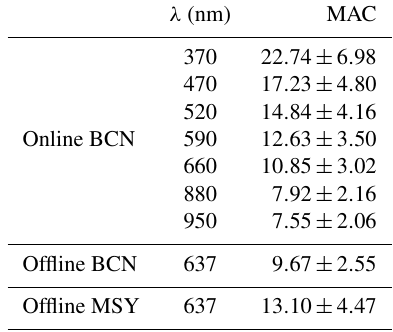
Table 1. Observed MAC (m 2 g − 1 ) values obtained using online techniques via AE33 and Sunset online EC measurements at BCN for a PM 2 . 5 inlet cut-off, and offline at BCN and MSY via MAAP and offline EC measurements on 24h filters for a PM 10 inlet cut-off. λ